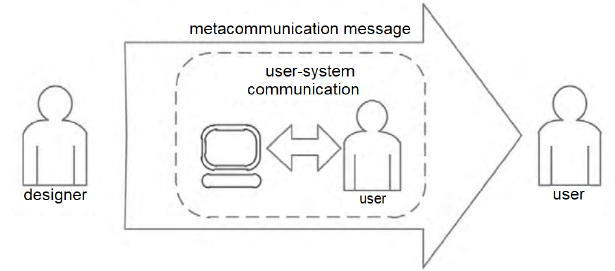
Figure 2. Designer–user metacommunication and user–system communica­